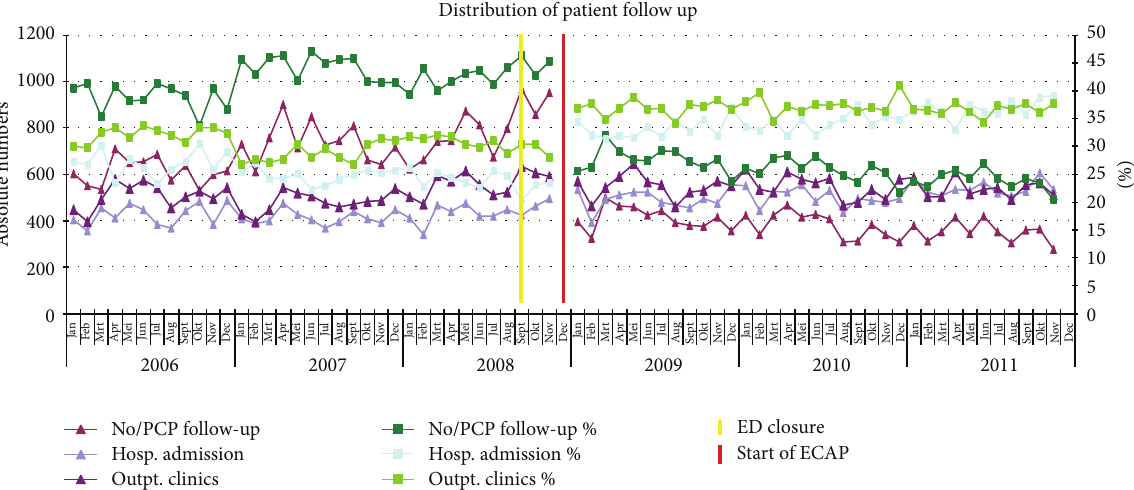
Figure 3: Distribution of patient follow-up. For visual reasons the percentage of deceased in the ED and transfer to another hospital is not shown in this figure. These percentages are very low and remained